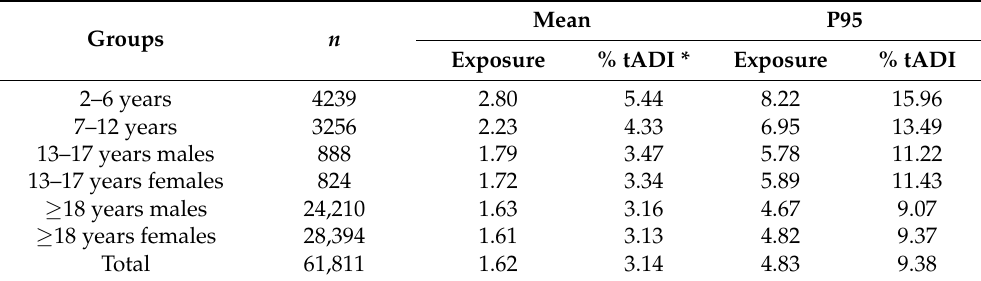
Table 2. Dietary mean and P95 exposure of total REEs estimated in the general population and different sex–age groups of the Chinese population ( µ g/kg